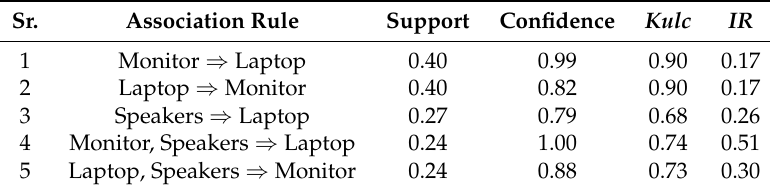
Table 9. House 3: Appliance association rules in 50% training dataset. Sr.